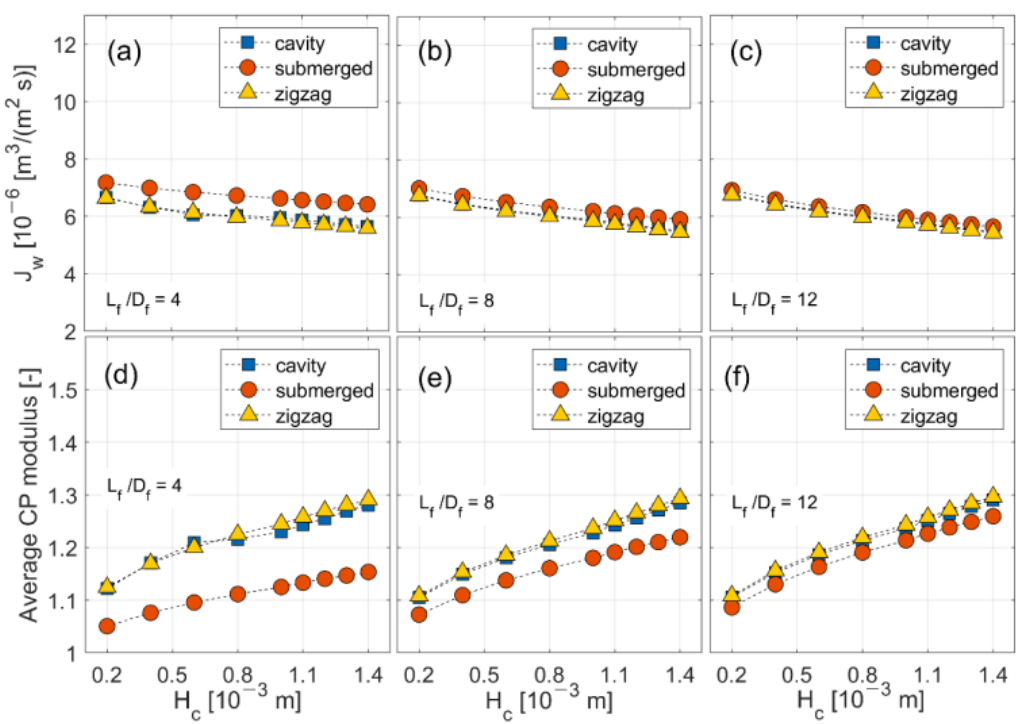
Figure 4. Average water fluxes (top) and CP moduli (bottom) in the cavity, submerged and zigzag configurations for varying channel height at selected filament length to diameter ( L f / D f ) ratios. ( a , d ): L f / D f =4; ( b , e ): L f / D f =8; ( c , f ): L f / D f =12.